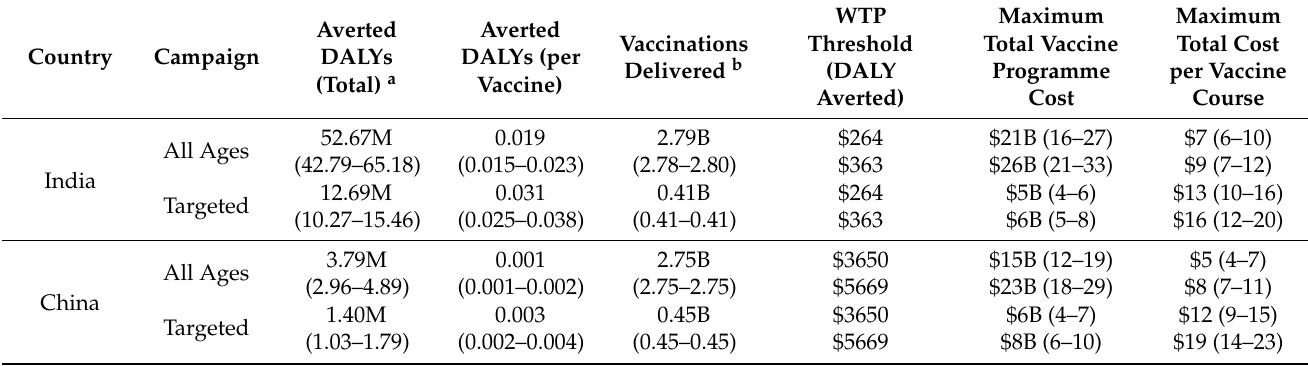
Table 1. Mass vaccine campaigns. Targeted vaccination in India was delivered to ages 50–59 and in China to ages 60–69. Results are aggregated over three campaigns delivered in 2027, 2037 and 2047. Averted DALYs and estimated net vaccine implementation costs are discounted to 2018 values at 3% per year. WTP: Willingness to